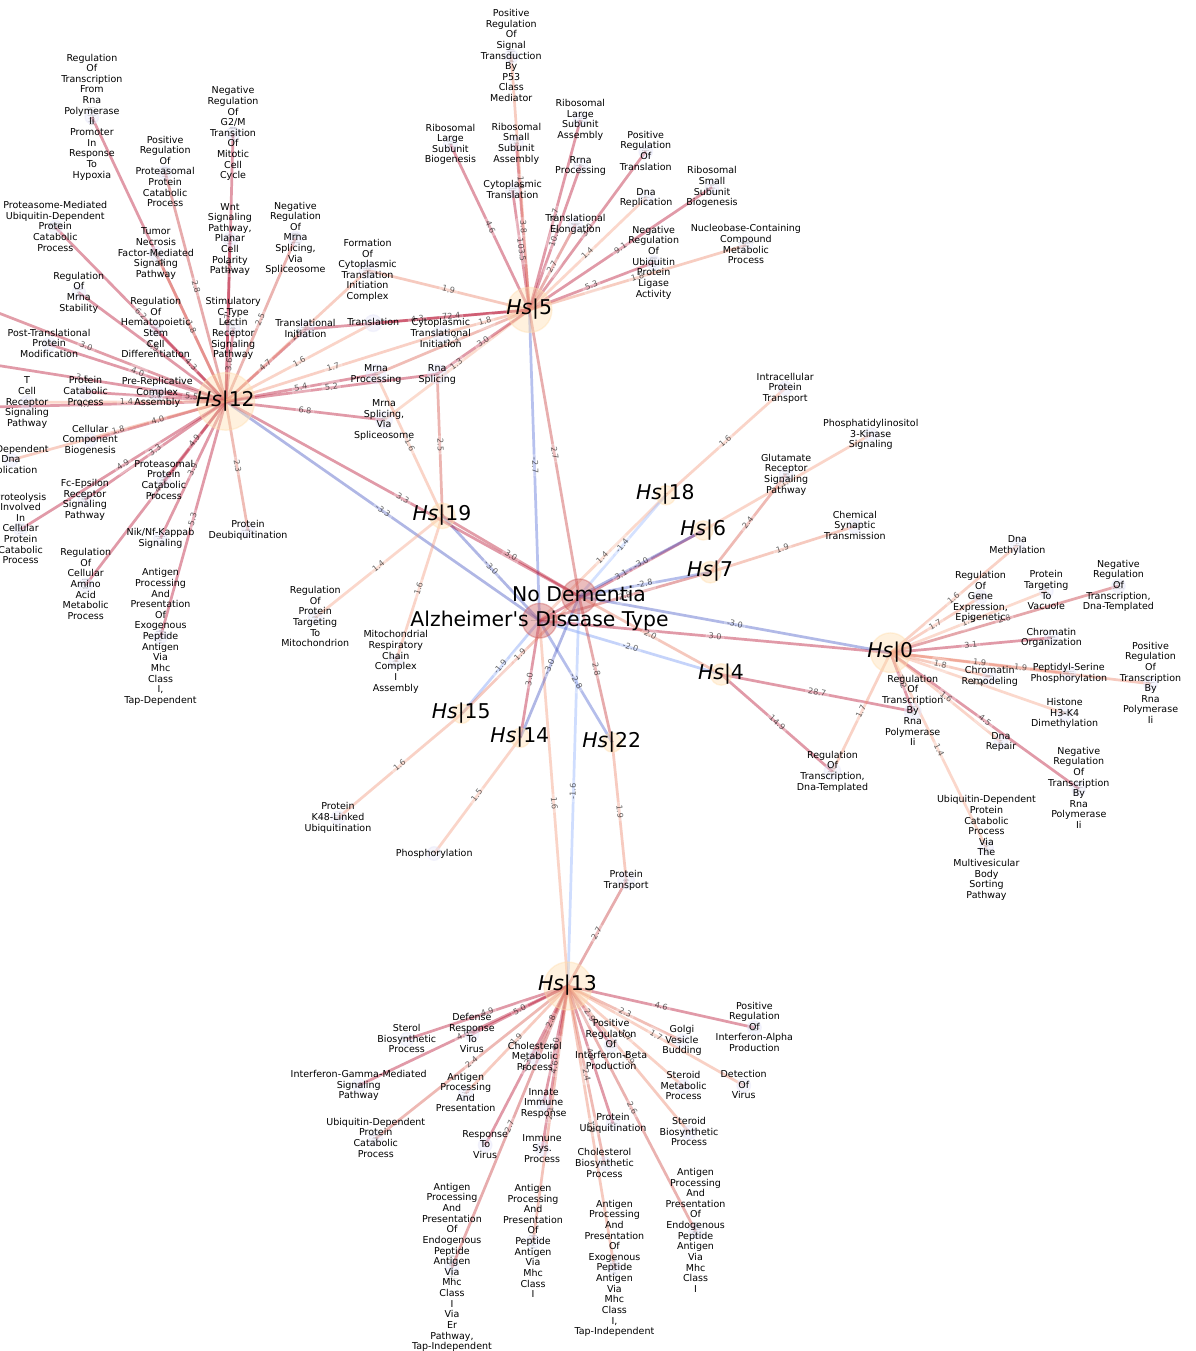
Figure 13. Statistically significant Normalized Enrichment GSEA Scores between Disease/Control conditions ( red nodes ) and GXN•OMP communities ( yellow nodes ), and statistically significant associations between GO terms ( blue nodes ) and GXN•OMP and GXN•EN communities, for the Alzheimer/Control H. sapiens